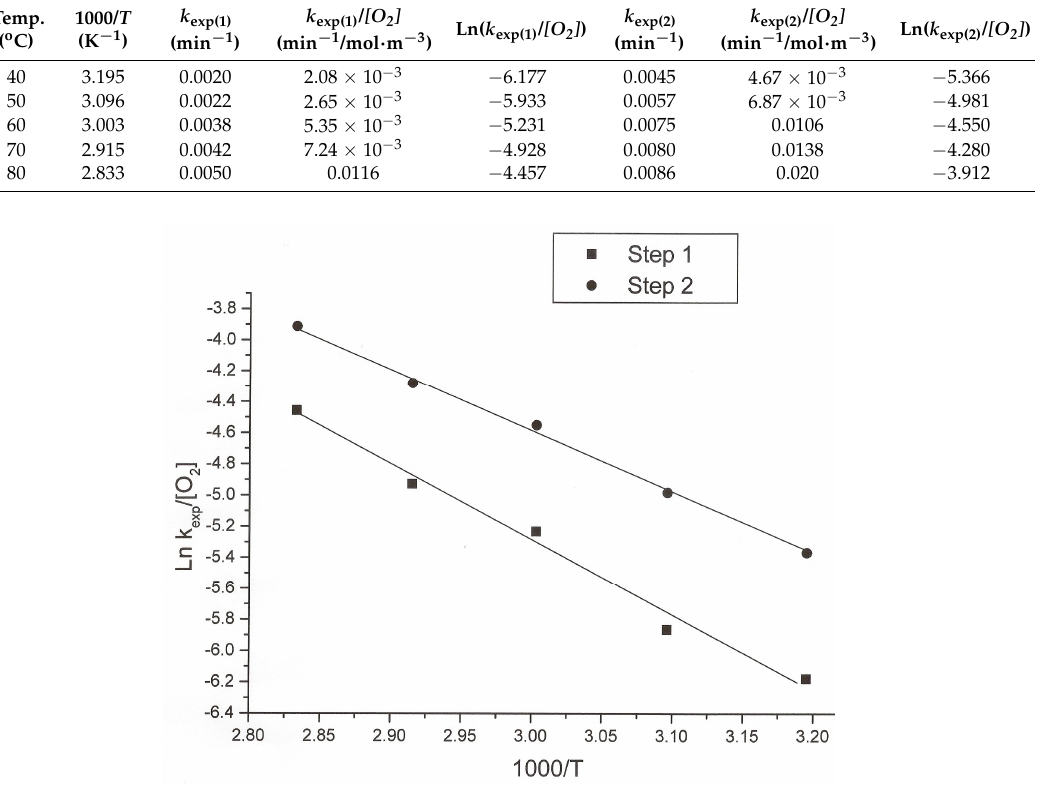
Figure 5. Apparent activation energy (E a ) for thiosulfate transformation (first step): 41 kJ·mol −1 , and (second step): 33 kJ·mol −1 .